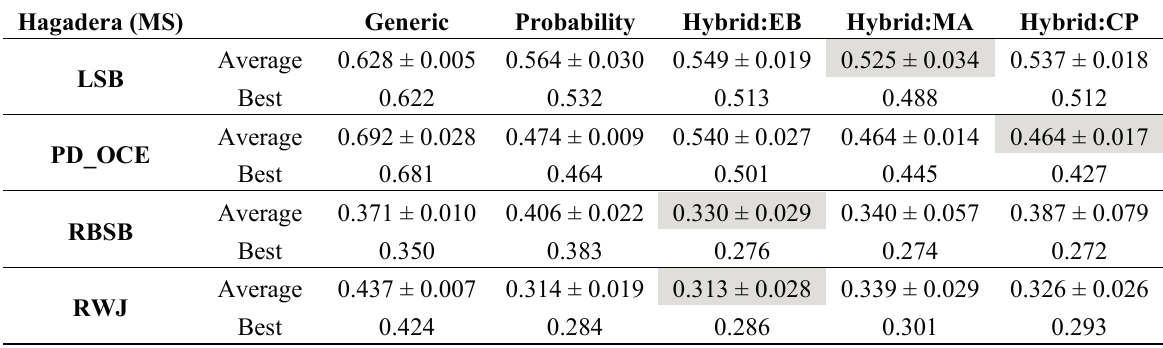
Table 5. Segmentation accuracies achieved in the Hagadera problem instance. The shaded cells highlight the results of the best performing hybridization